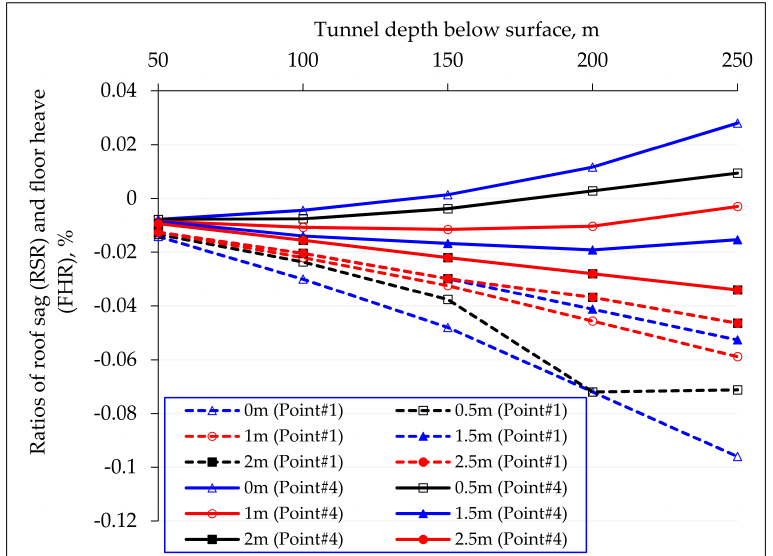
Figure 17. Roof sag and floor heave percent at various tunnel depths below surface (e.g., are measured at different vertical distances from tunnel boundary).